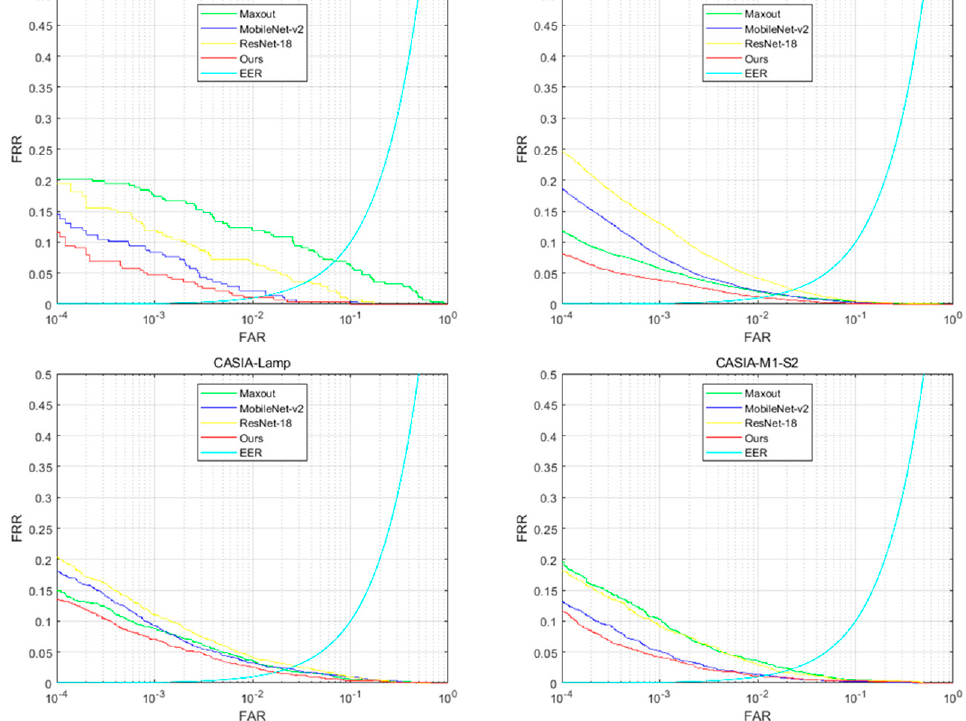
Figure 7. DET curves obtained from iris verification experiments conducted using ResNet-18, Maxout-CNNs, MobileNet-v2, and the proposed method.